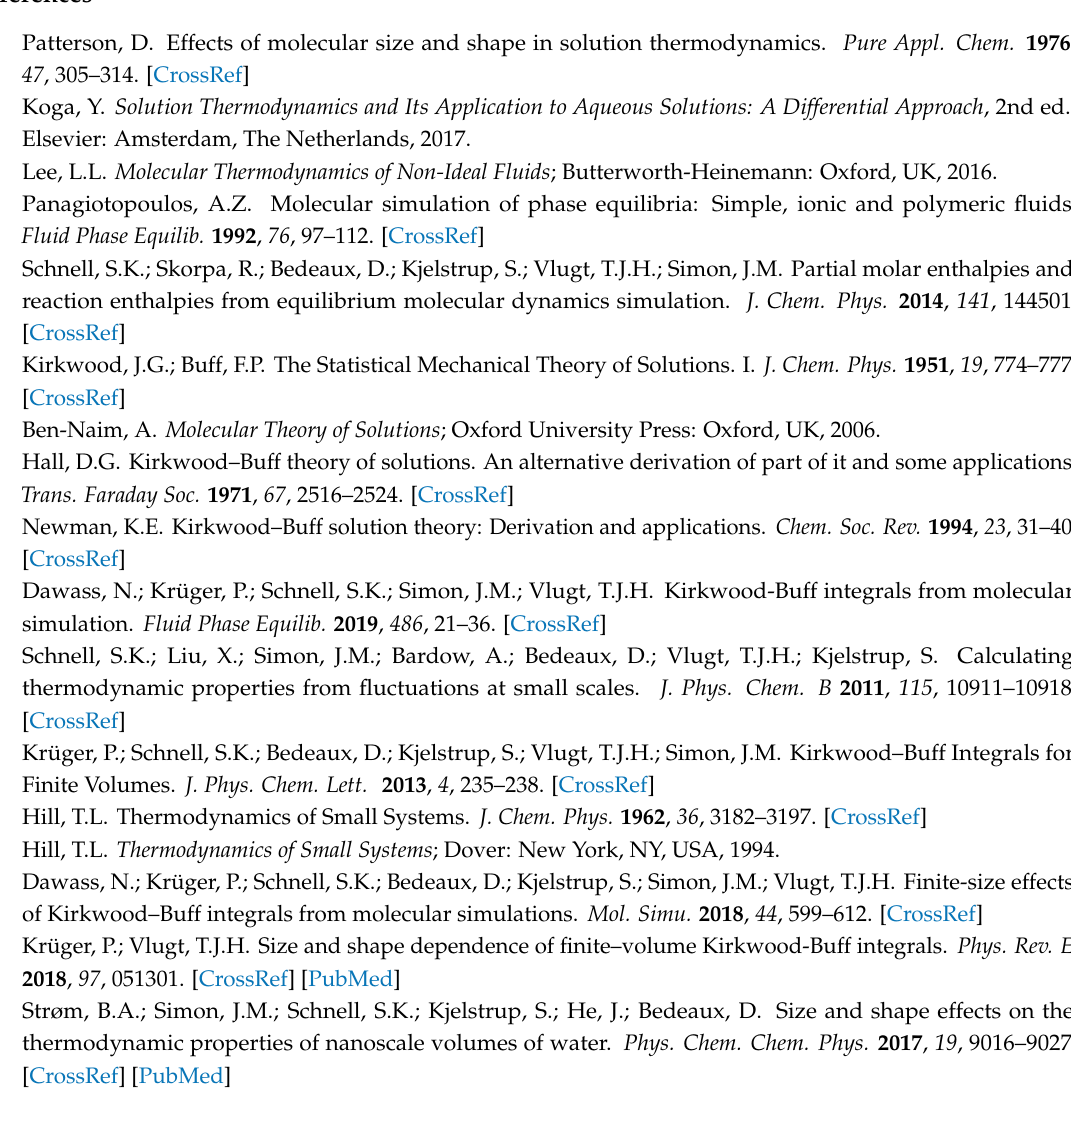
Tables S1–S16: KB integrals G ∞ and the surface term F ∞ in the thermodynamic limit are provided at different densities for the LJ and WCA fluids. For each interaction potential, G ∞ and F ∞ are computed at a dimensionless temperature T = 2 and the following dimensionless densities: ρ = 0.2, ρ = 0.4, ρ = 0.6, and ρ =